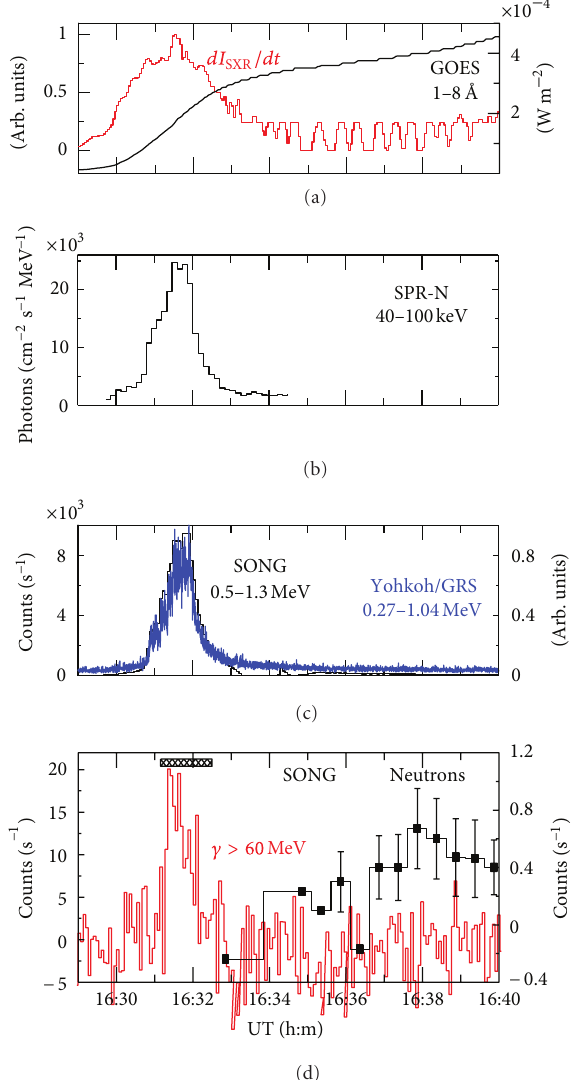
Figure 1: Time profiles of selected emissions from the August 25, 2001, flare: (a) soft X-ray flux (hereinafter black curve and right 𝑦 -axis) and its derivative (hereinafter red curve and left 𝑦 -axis); (b) hard X-ray 40–100keV from CORONAS-F/SPR-N; (c) gamma-rays 0.5–1.3 MeV (CORONAS-F/SONG, black curve, left 𝑦 -axis) and 0.27–1.04 MeV (Yohkoh/GRS, blue curve, right 𝑦 -axis; http://solar.physics.montana.edu/sxt/); (d) gamma-rays > 60MeV (red, left 𝑦 -axis) and neutrons (black, right 𝑦 -axis) from CORONAS-F/SONG. Shaded rectangle in bottom panel denotes hereinafter the interval of undoubted observation of the pion-decay gamma-emission.